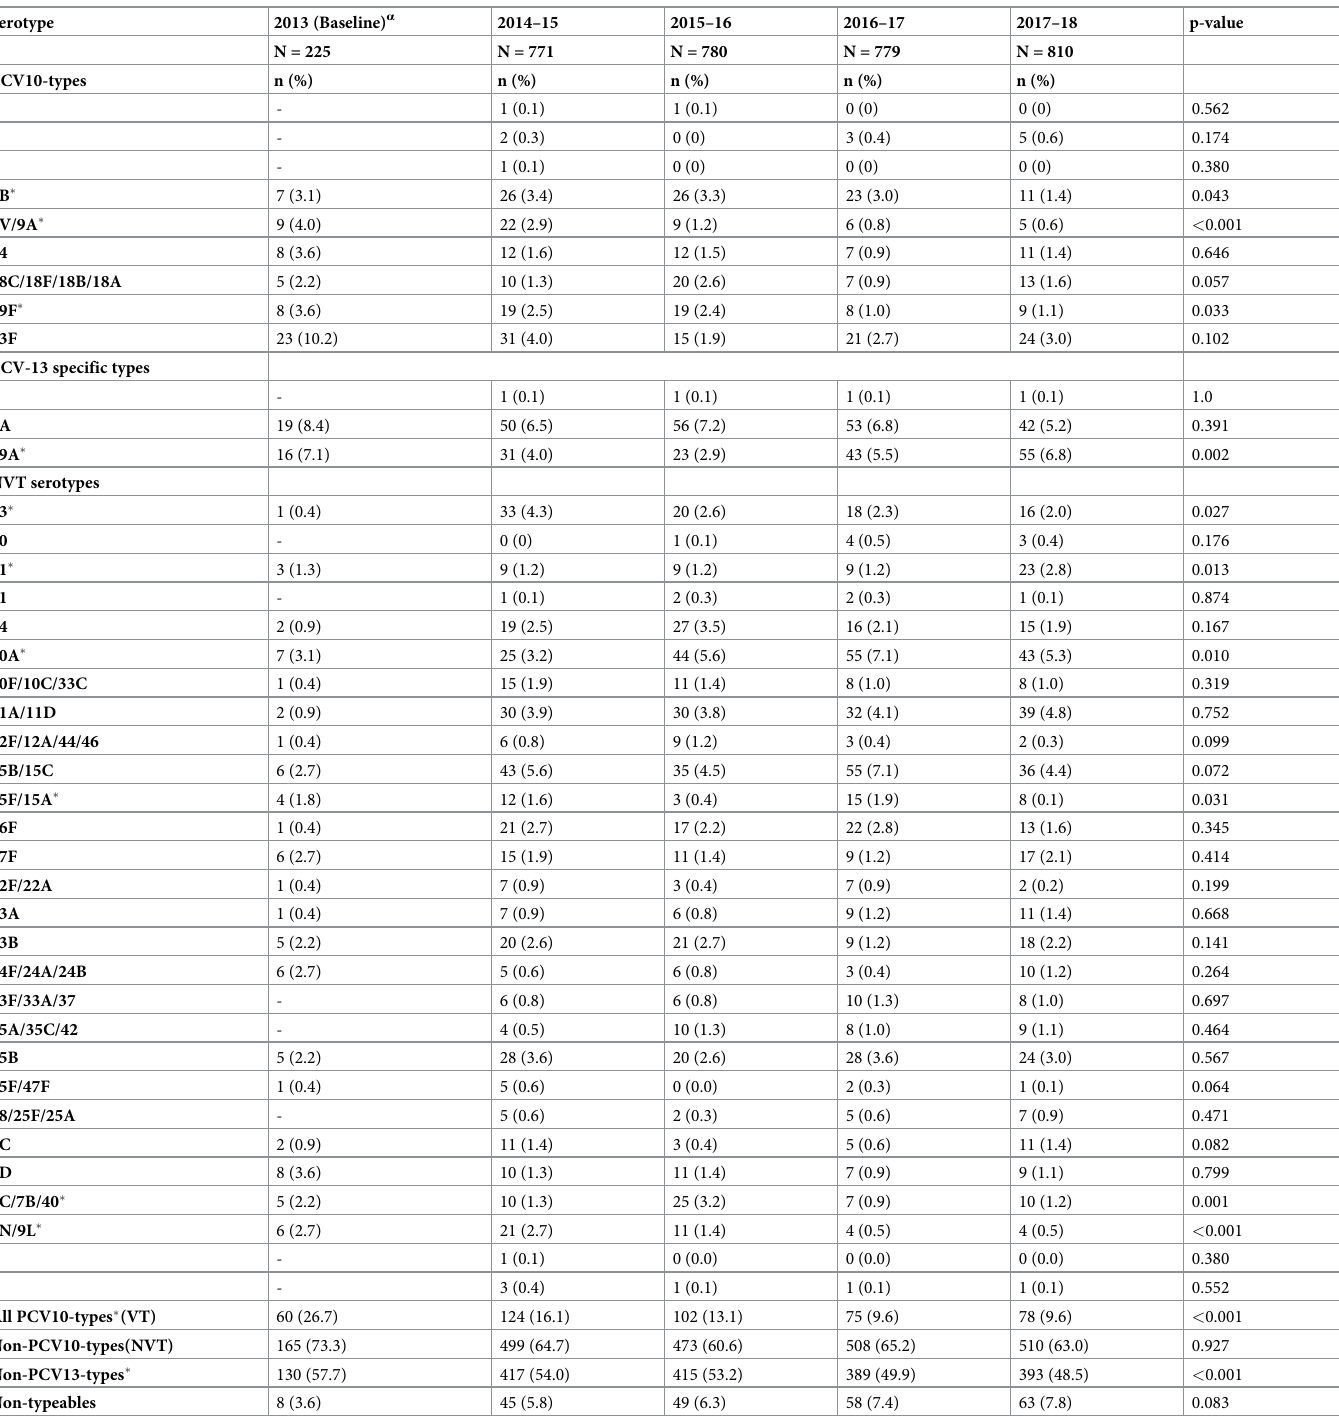
Table 1. Serotype specific carriage rate from 2014–18 in Matiari, Pakistan.